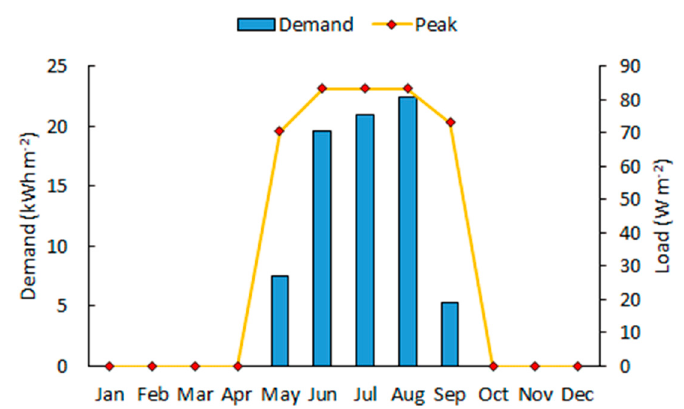
Figure 11. Monthly cooling demand and peak loads.